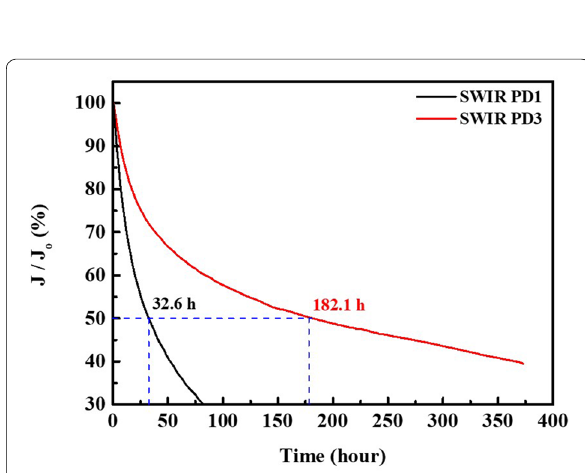
Fig. 8 Lifetime characteristics of SWIR PD1 and SWIR PD3. Lifetime characteristics of SWIR PD1 (black line) and SWIR PD3 (red line) without encapsulation, under constant voltage operation room